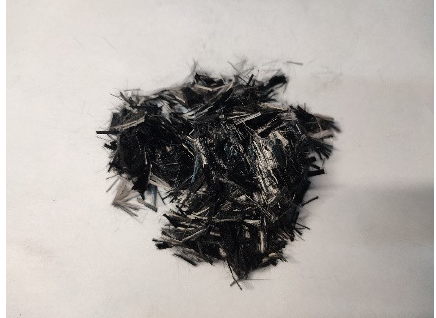
Figure 1. Basic morphology of carbon fiber after cutting.